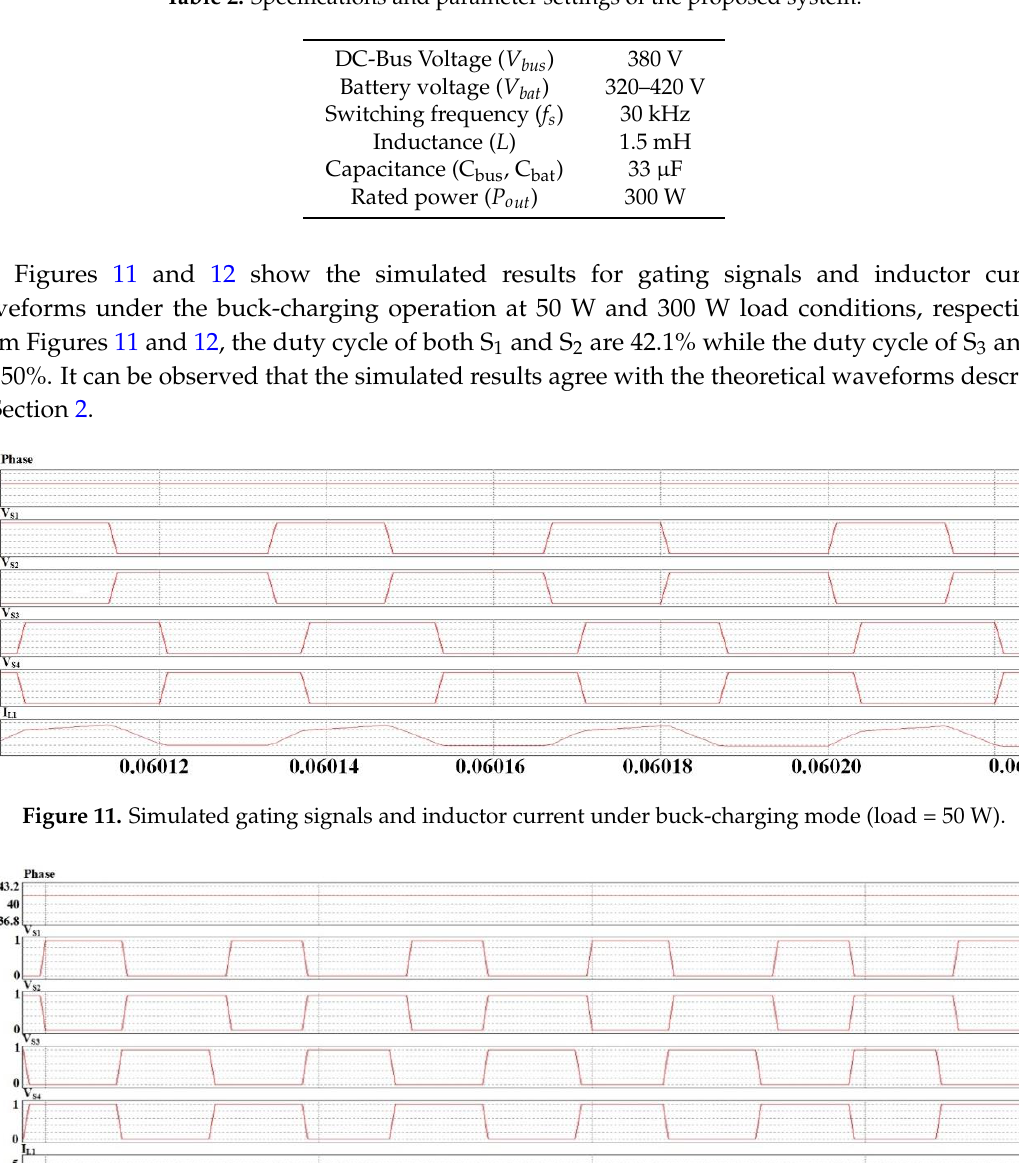
Table 2. Specifications and parameter settings of the proposed system.